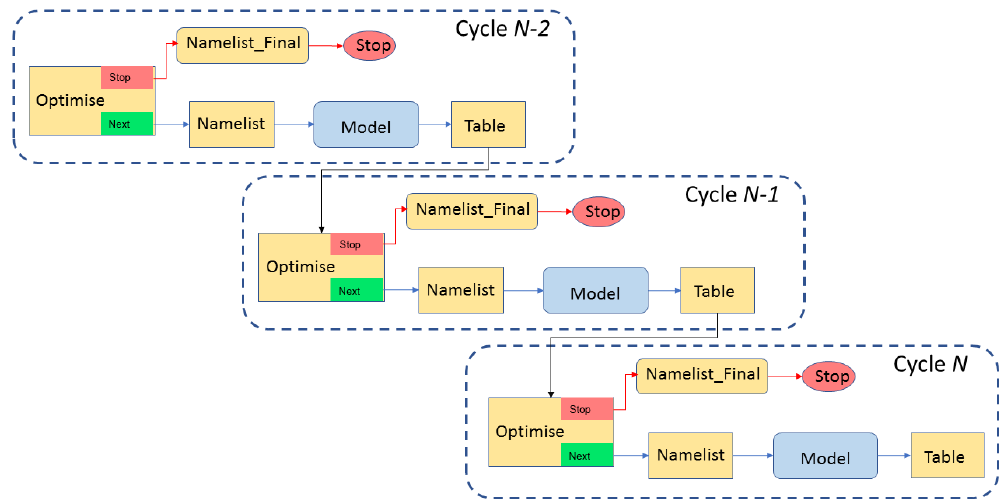
Figure 1. Dependency graph for a version of the Cyclops optimisation suite in which no concurrent simulations are allowed, showing three successive cycles. Arrows represent dependency, in that a task at the head of an arrow depends on the task at the tail of the arrow meeting a specified condition (by default, this means completing successfully) before it can